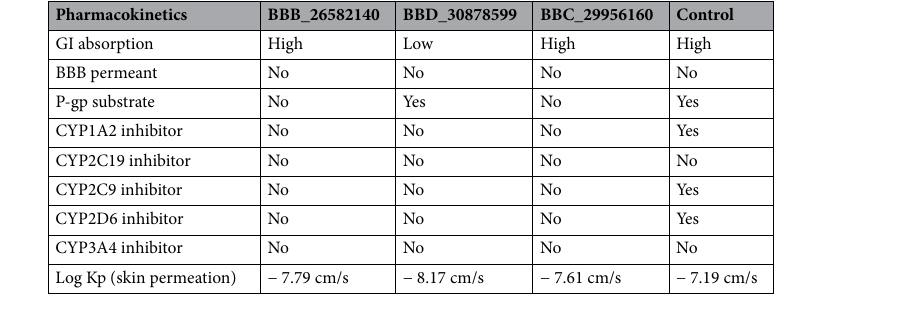
Table 3. Pharmacokinetics analysis of compounds and